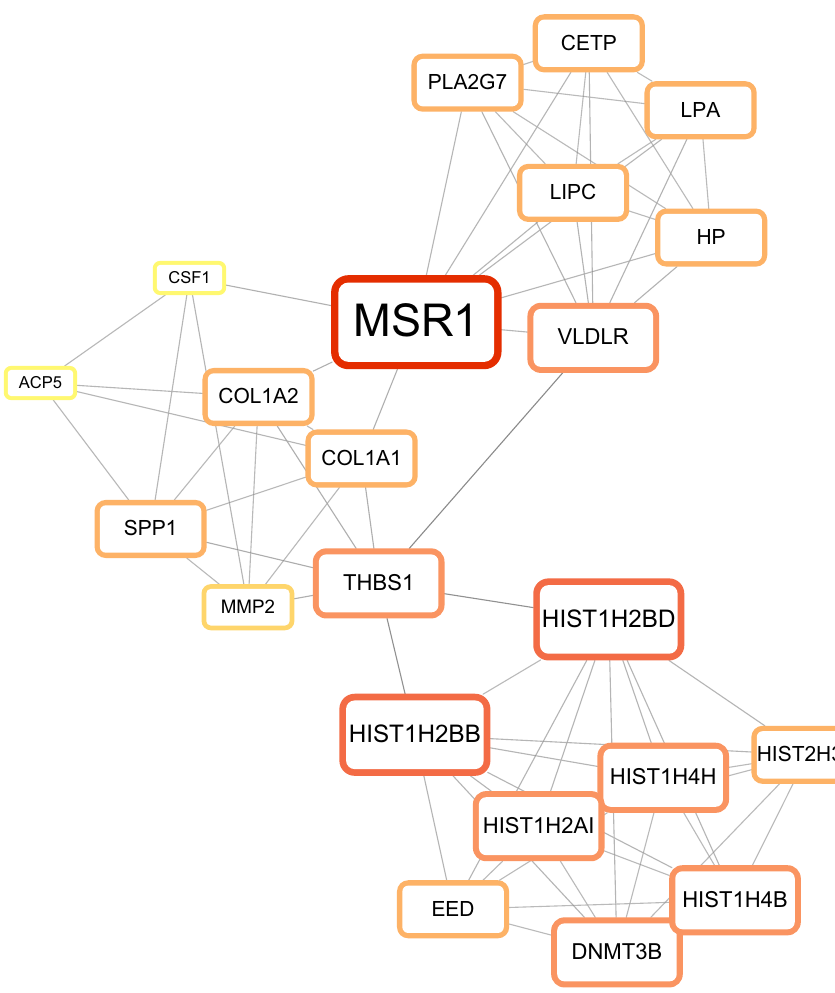
Figure 3. Subnetwork of 27 hub genes from the protein–protein interaction (PPI) network. Node size and temperature color reflect the degree of connectivity (bigger node represents a higher degree and smaller node represents a lower degree; red node represents a higher degree and yellow node represents a lower